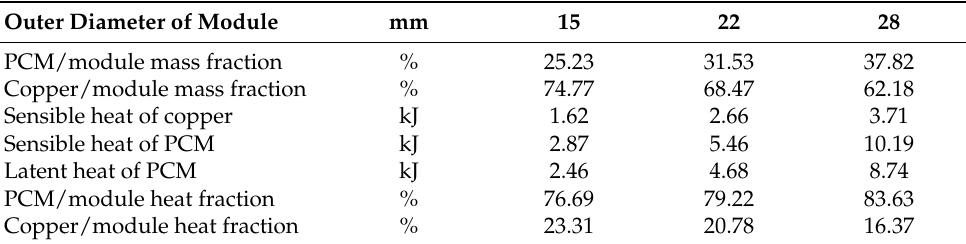
Table 2. Contributions of the module components in heat transfer.